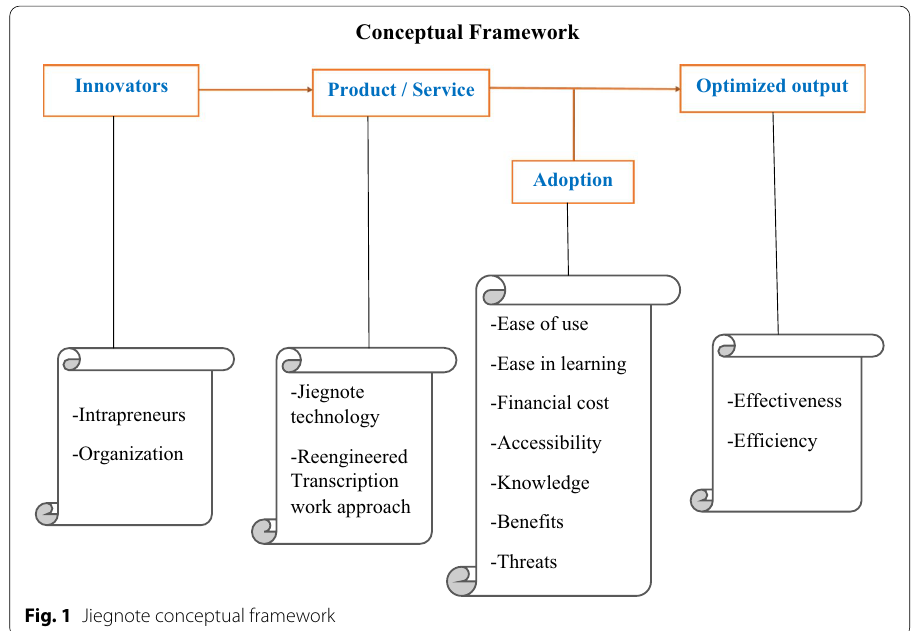
Fig. 1 Jiegnote conceptual